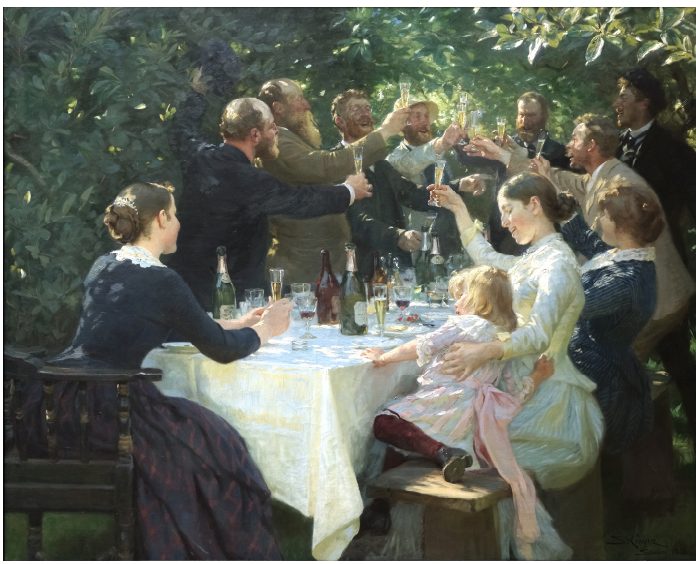
Figure 5. P.S. [Peder Severin] Krøyer (1851–1909): Hip, hip, hurra! Kunstnerfest på Skagen (“Hip, hip, hooray! Artists’ Celebration in Skagen”), 1884–1888, oil on canvas, 134.5 cm × 165.5 cm, Göteborgs Konstmuseum, Public